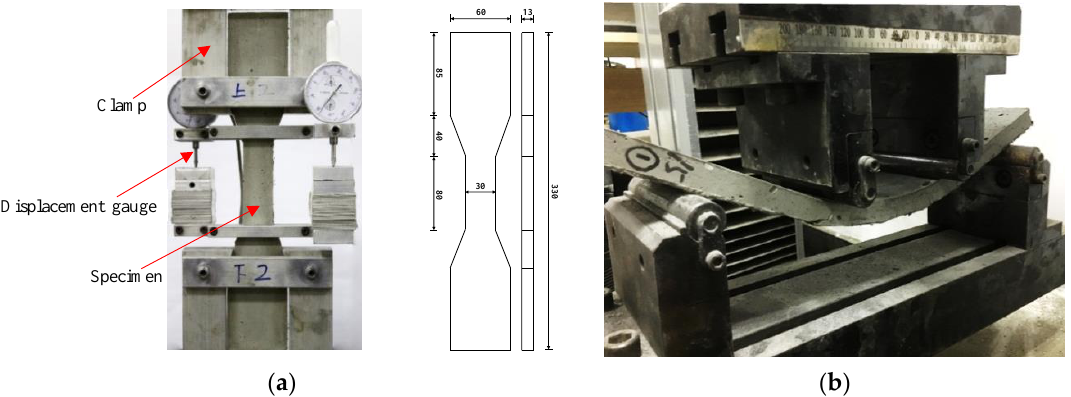
Figure 3. Mechanical performance tests: ( a ) Tensile test, ( b ) Bending test.